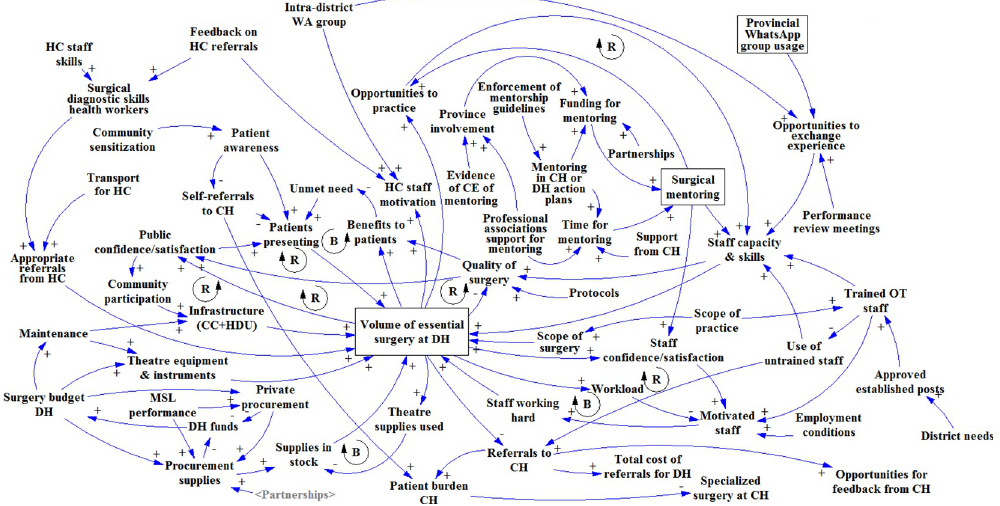
Fig 5. Causal loop diagram as it was built in the GMB workshop in